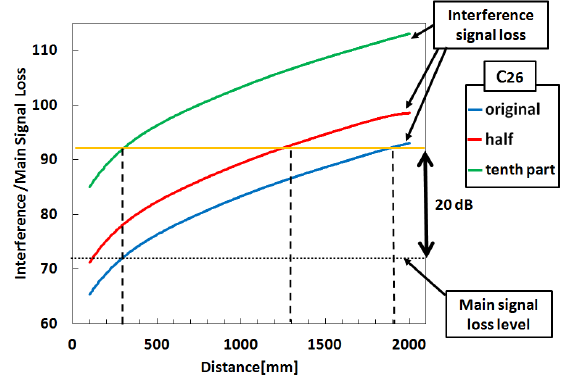
Figure 14. Effect of interference signal loss by varying C 26